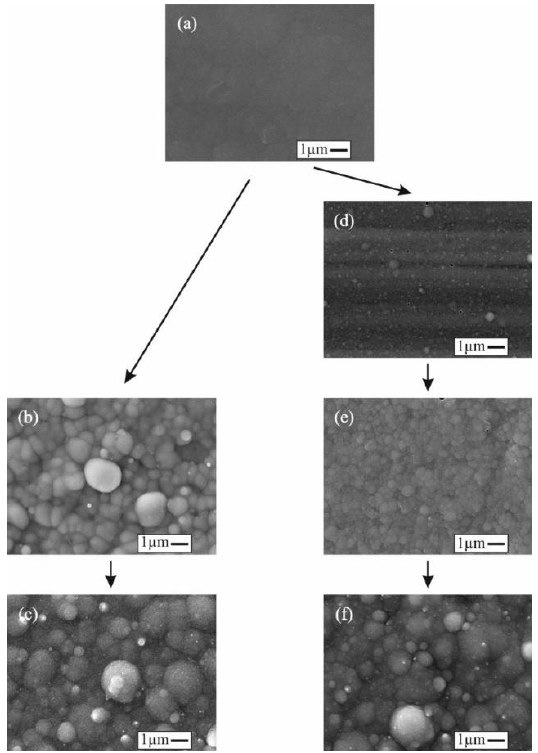
Figure 5. SEM images of surface morphology of the different layers deposited on the contact blades. The sequence (a – b – c) was acquired for Au – Ru coatings: ( a ) initial Fe – Ni polished surface, ( b ) Au layer, ( c ) Ru layer. The sequence ( a – d – e – f ) was acquired for Au – Ru coatings with Co – W sublayer: ( a ) initial Fe – Ni polished surface, ( d ) Co – W sublayer, ( e ) Au layer, ( f ) Ru layer.